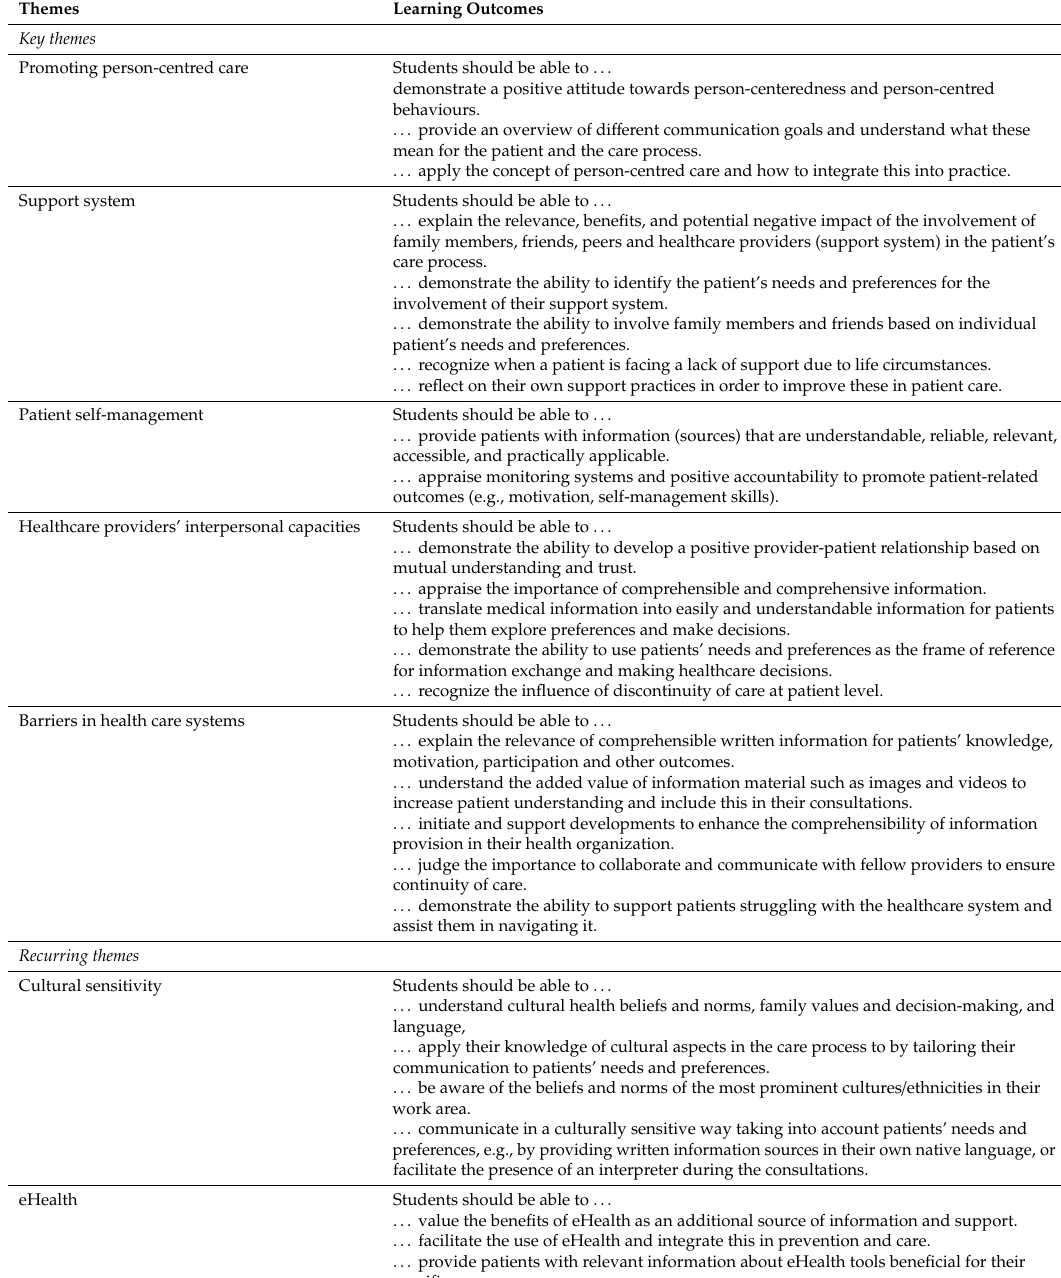
Table 4. Learning outcomes based on the perspectives of patients with chronic diseases and limited health